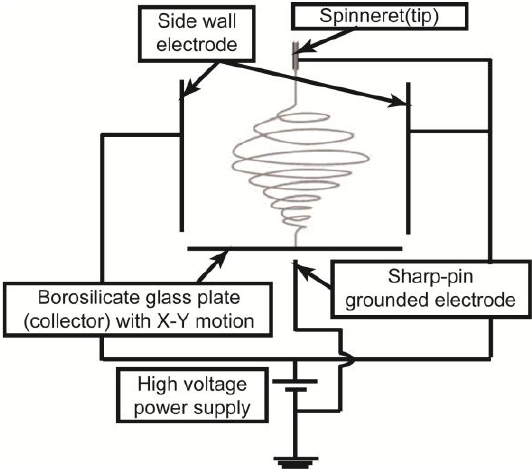
Figure 6. Schematic diagram of the direct-write electrospinning (DWES)